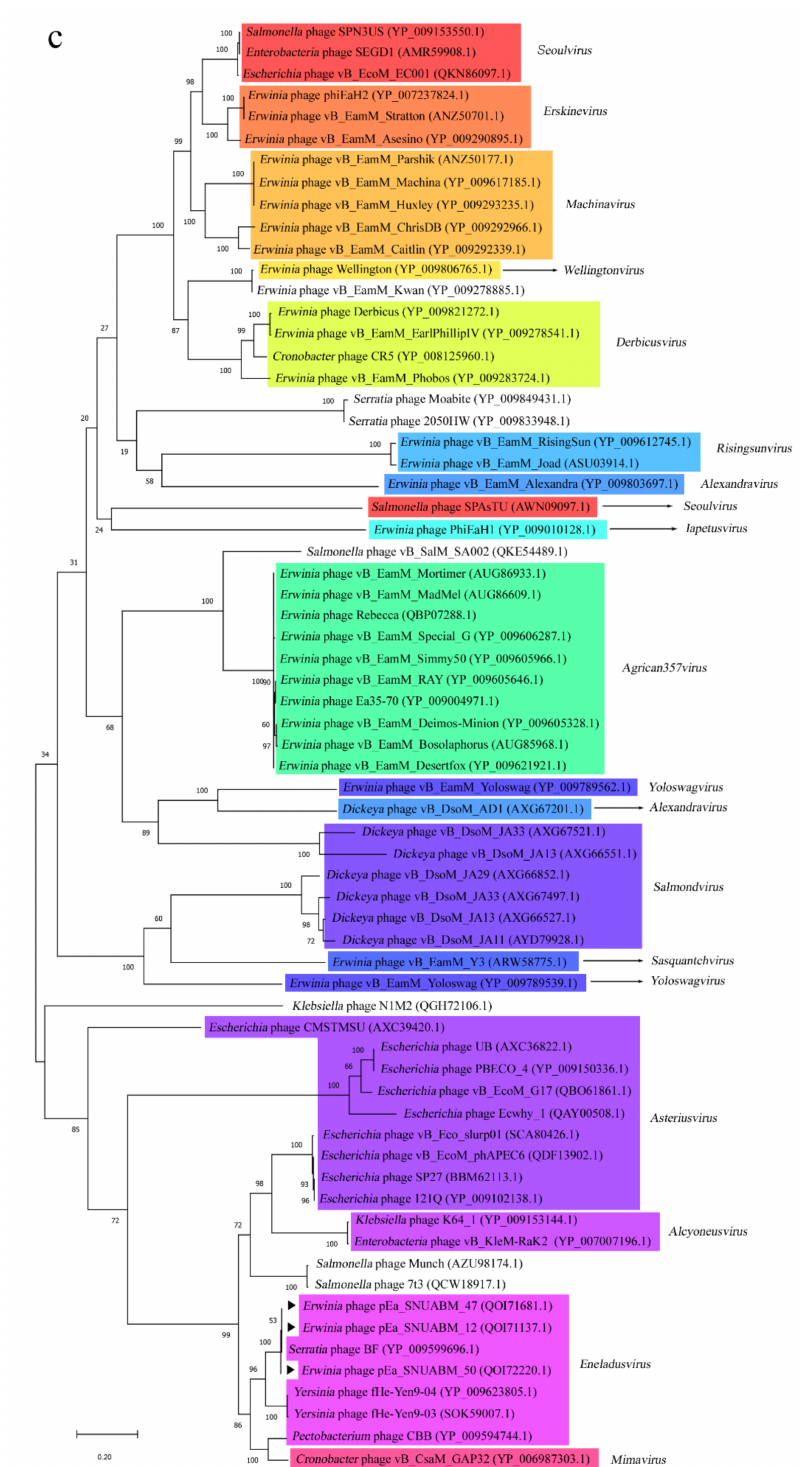
Figure 4. Phylogenetic analysis of Myoviridae jumbo phages infecting Enterobacterales using major capsid protein ( a ); terminase large subunit ( b ); tail sheath protein ( c ); the phylogenetic trees were created from MEGA with the maximum likelihood algorithm. The phages isolated in this study were indicated with black arrow ( (cid:73)